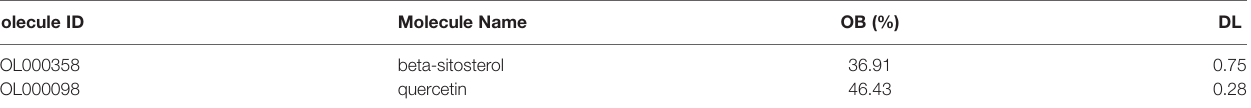
signi fi cantly increased DNA damage in a dose-dependent manner, as measured by the percentage of DNA in the tails ( Figure 6A ).